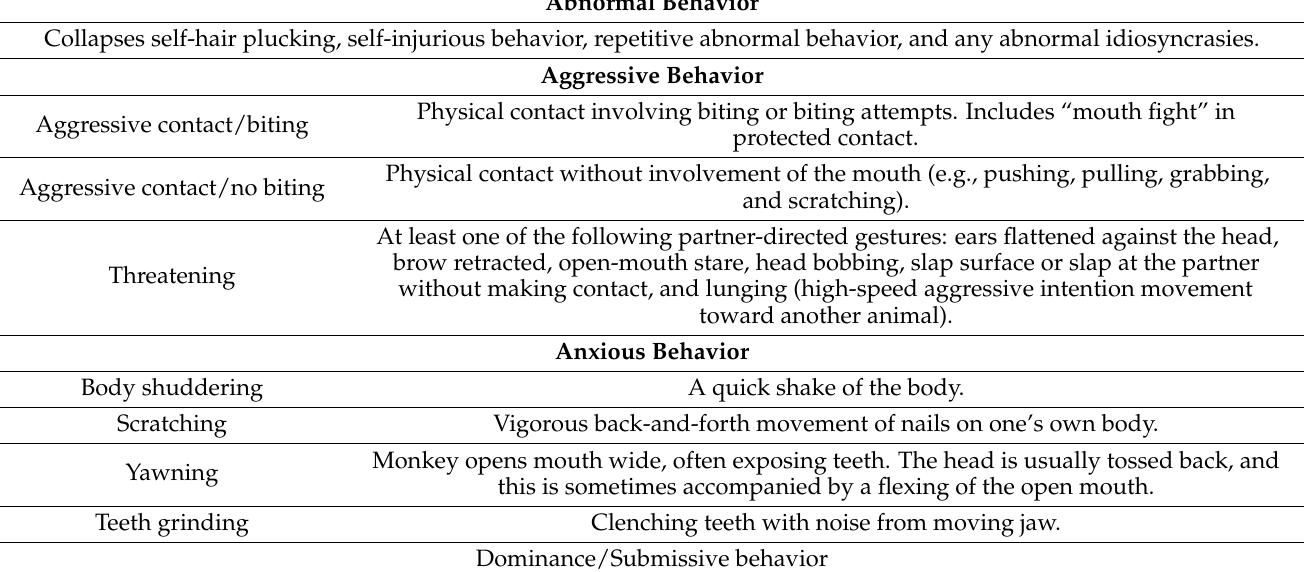
Table 1. Abnormal, aggressive, anxious, dominance/submissive, and affiliative behaviors recorded during social introductions. Abnormal Behavior Collapses self-hair plucking, self-injurious behavior, repetitive abnormal behavior, and any abnormal idiosyncrasies. Aggressive Behavior Aggressive